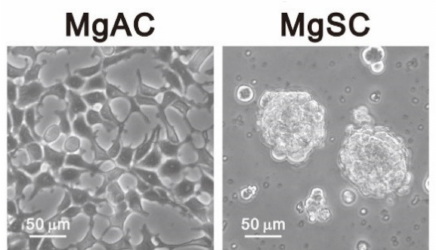
Figure 1. Morphology of adherent meningioma cells (MgACs) and meningioma sphere cells (MgSCs). For MgSCs, we collected MgACs and cultured them for 2 days in DMEM/F12 (Corning, Glendale, AZ, USA) supplemented with N2 (Thermo Fisher Scientific, Waltham, MA, USA), epidermal growth factors (EGF, PeproTech Asia, Rehovot, Israel), and fibroblast growth factors (FGF, PeproTech, Asia, Rehovot, Israel) to form the sphere cells. Scale bar: 50 µ